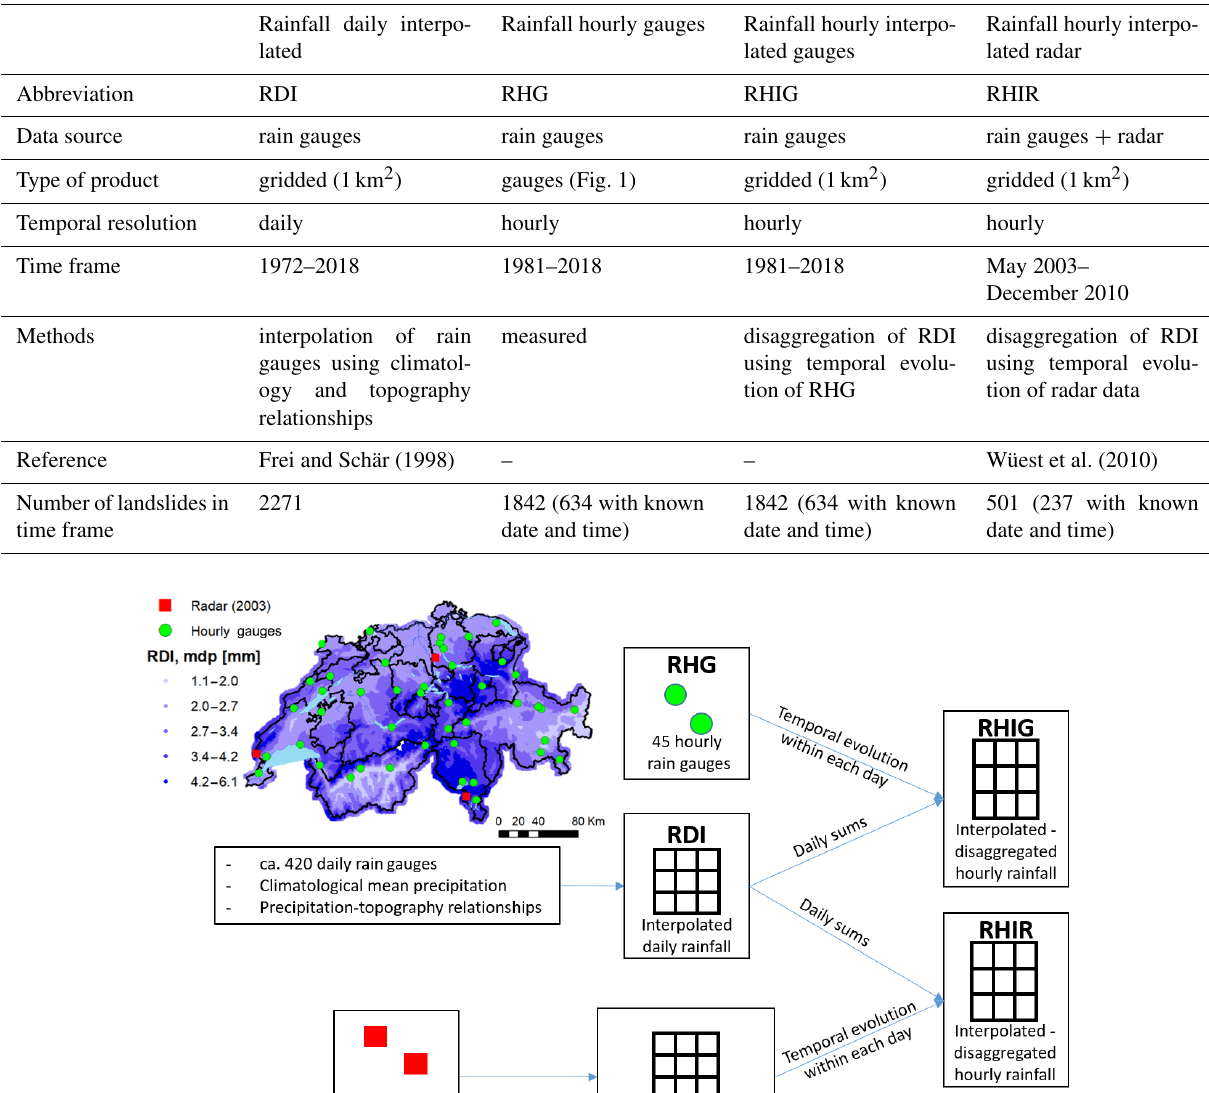
Table 1. Description of the different rainfall datasets used.